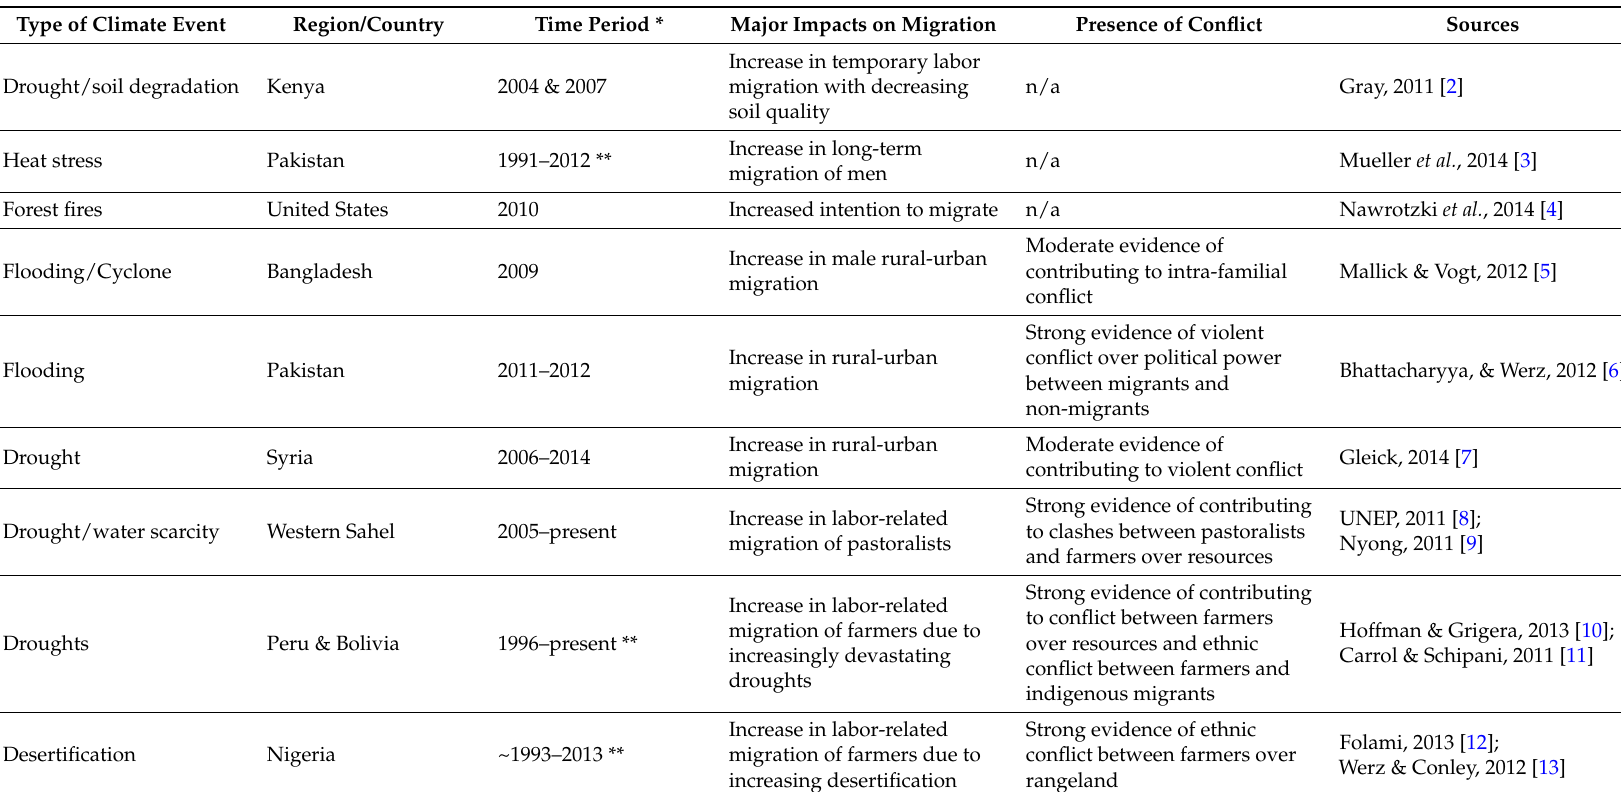
Table 1. Examples of climate extremes leading to migration and conflict since 2000. Despite the increasing body of literature on the theory and potential for climate related migration to result in conflict, there are surprisingly few case studies on recent climate extremes that lead to migration and conflict (see Reuveny, 2007 for a meta-analysis of historical examples) [1]. We have selected a number of key examples that are representative of the current